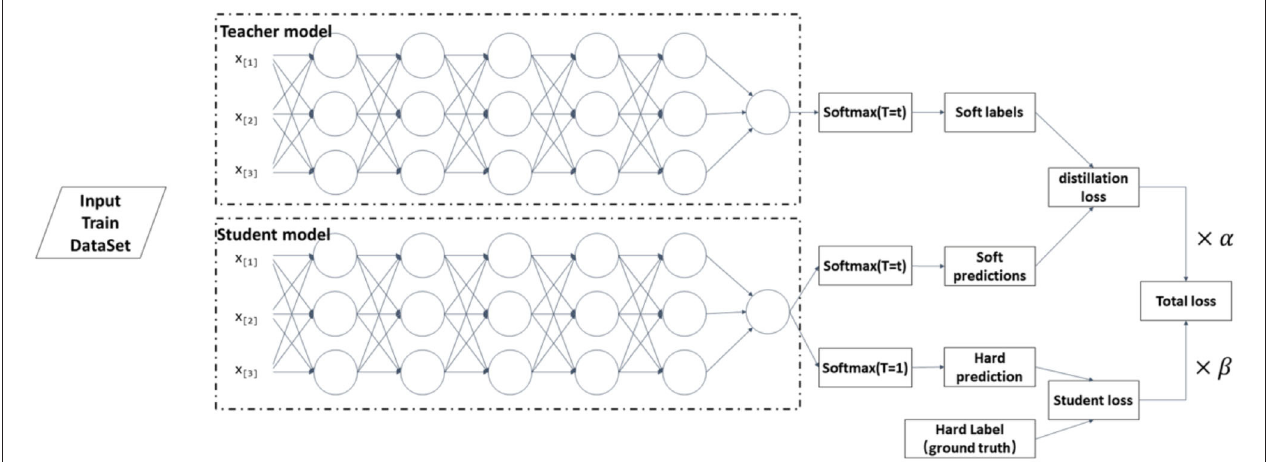
FIGURE 4 | Step of knowledge